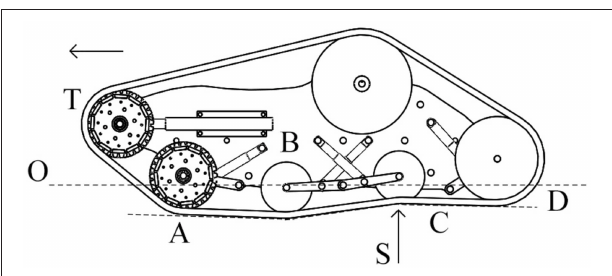
FIGURE 5 | Another example of suspension